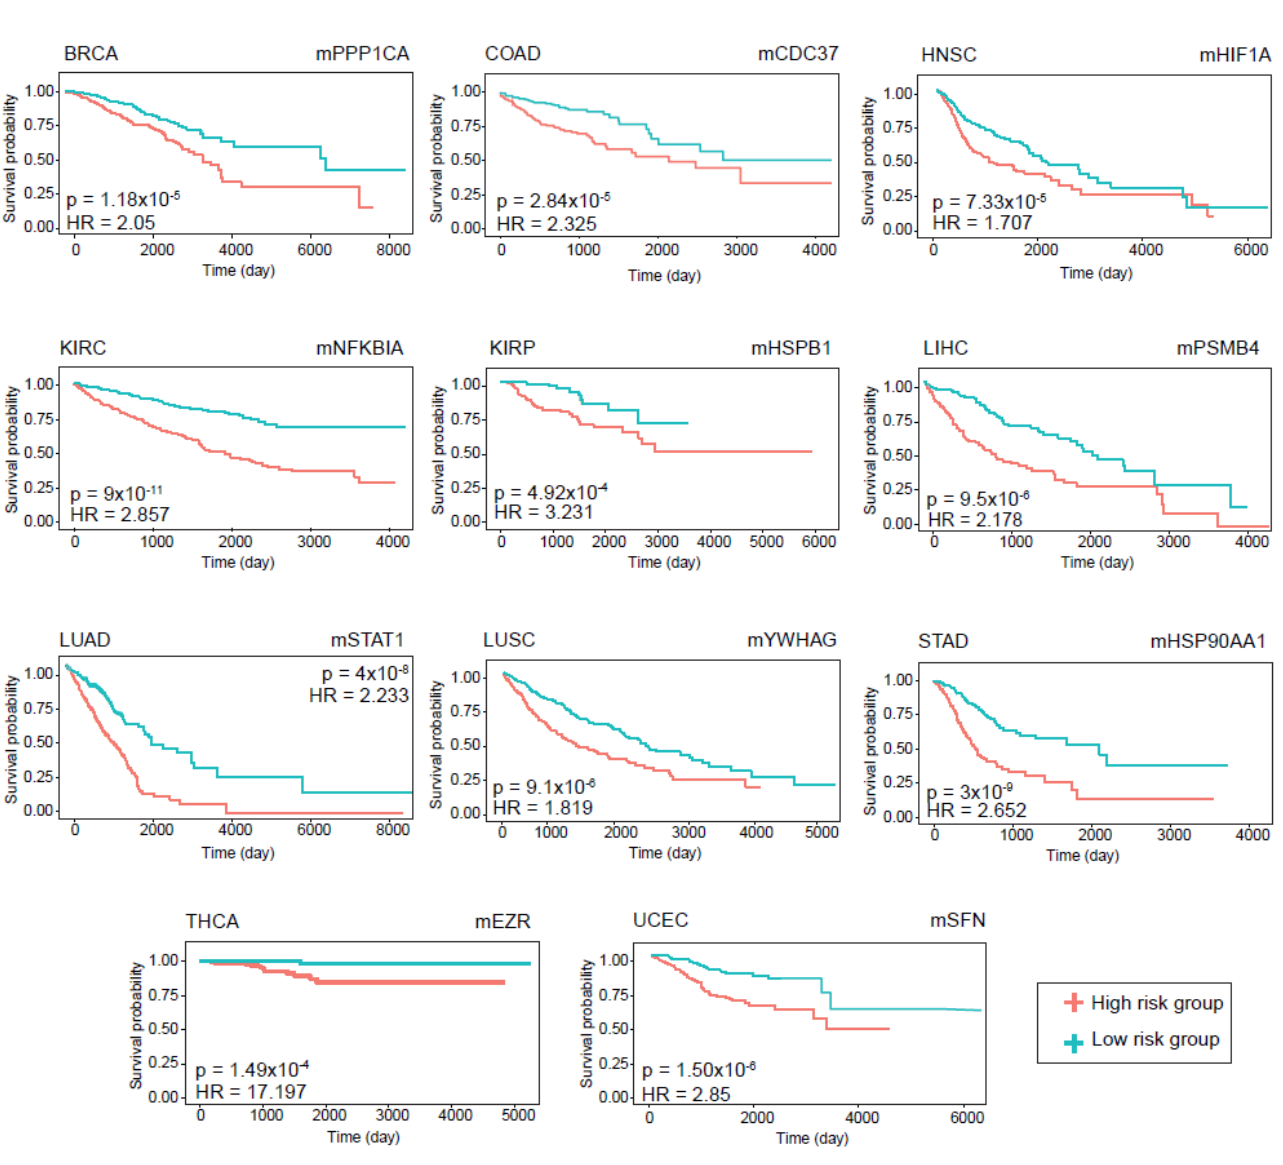
Figure 6. Prognostic analyses for different types of cancer. Kaplan–Meier Plots estimating patients’ survival for 11 cancers with p-value and hazard ratio given for each curve.